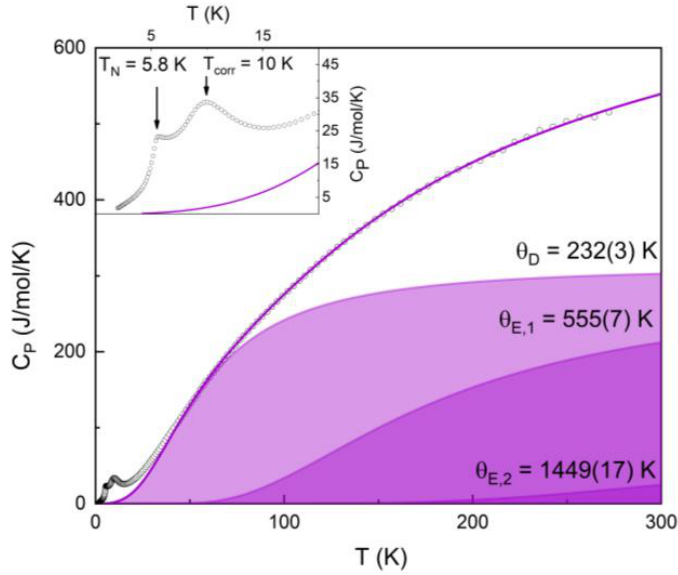
Figure 5. Temperature-dependent specific heat of Ba 2 Mn 3 (SeO 3 ) 6 described by the sum of Debye and two Einstein functions. The inset shows a zoomed-in view of the low temperature region along with the fitting curve.